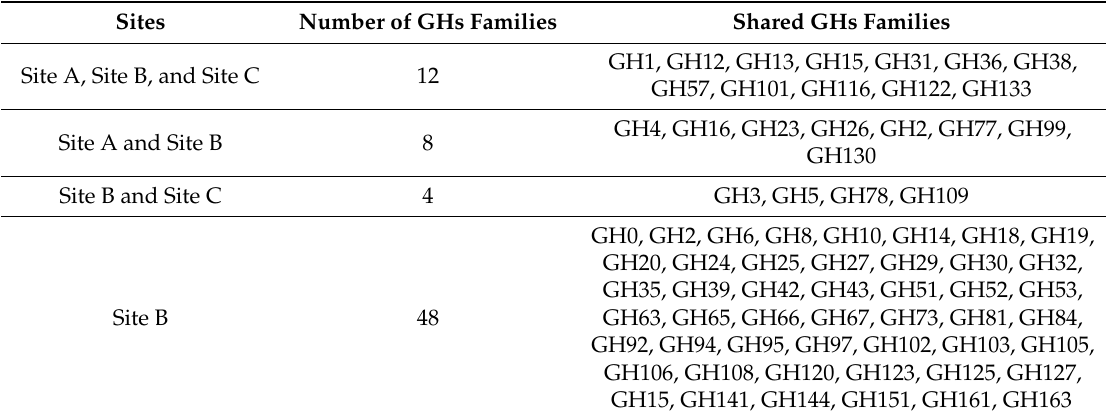
Figure 9. Identity percentages of the CAZymes annotated in the sites A, B, and C against homologs in the Refseq Protein Database. Table 7. Shared GHs families among the